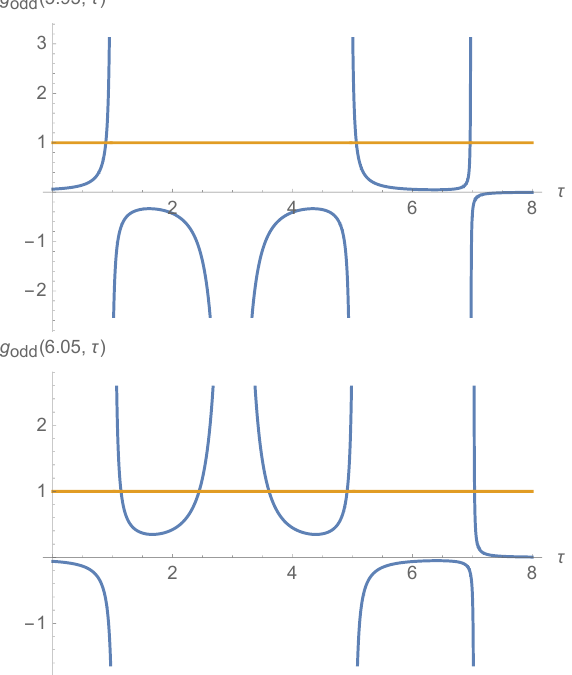
Figure 7. A plot g odd ( (cid:28) ) and 1 for d = 5 : 95 (top) and d = 6 : 05 (below). We see that some eigenvalues become real as one crosses d = 6.